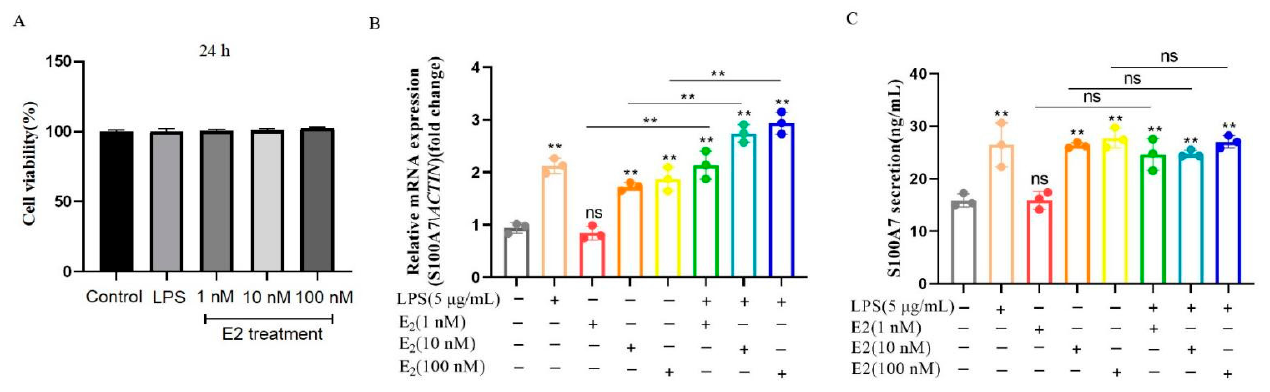
Figure 4. E2 induced mRNA expression and secretion of S100A7 in cultured gMECs. ( A ) Cell viability of gMECs with LPS or estradiol treatment for 24 h; ( B ) S100A7 expression of gMECs with LPS or estradiol treatment for 6 h; ( C ) S100A7 secretion of gMECs with LPS or estradiol treatment for 6 h; ns: p > 0.05; **: p < 0.01. Different colors stand for different groups. The cell viability(OD) for ( A